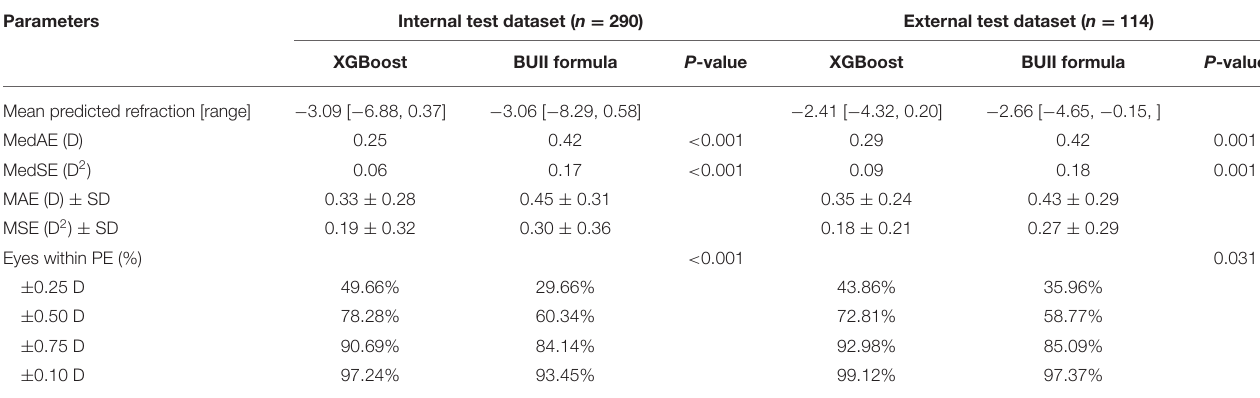
TABLE 3 | Summary of outcomes for the XGBoost calculator and the Barrett Universal II formula for the internal and external test datasets. Parameters